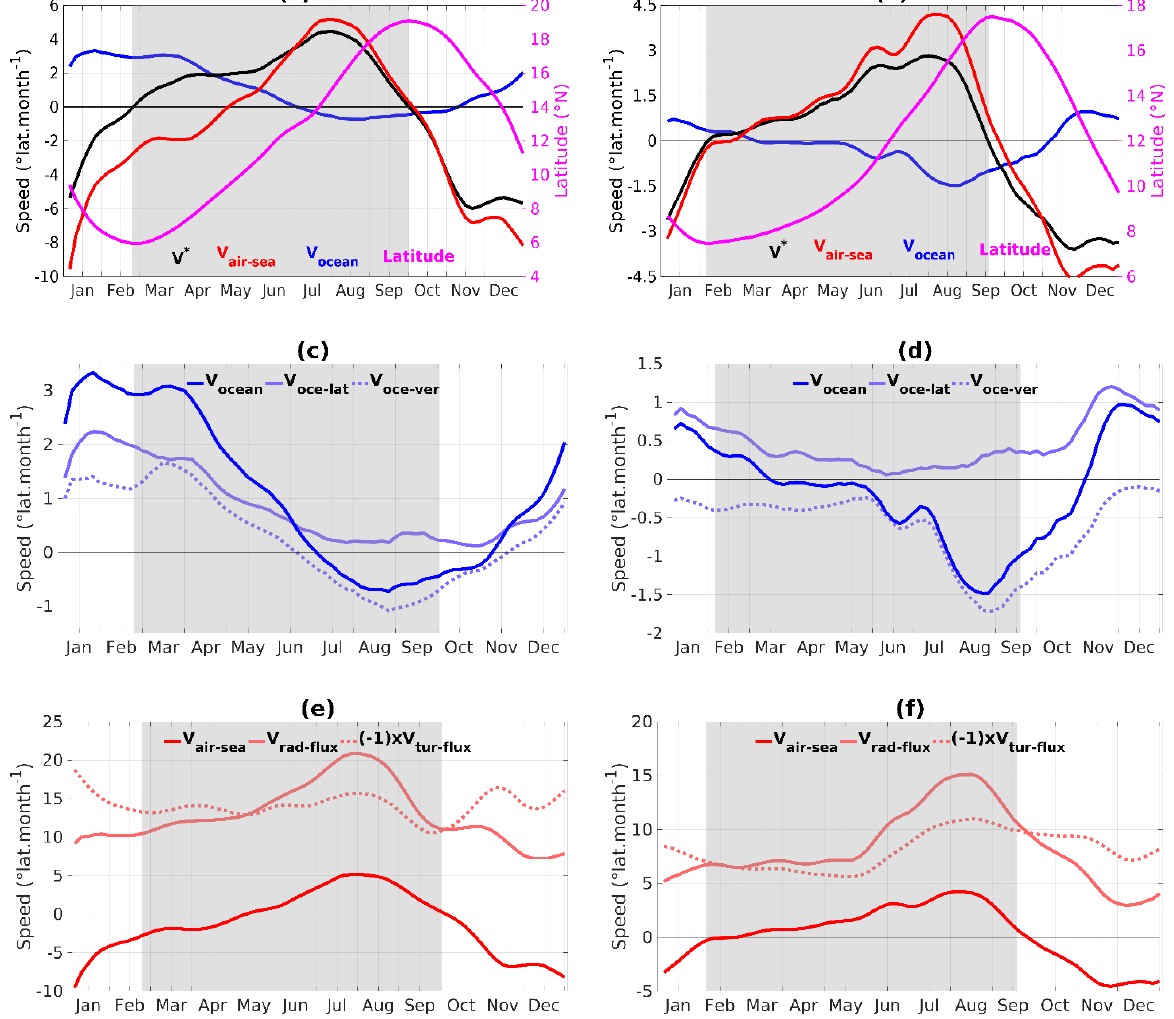
Figure 5. Velocity contributions ( ◦ lat.month − 1 ) for NB, averaged over the W30 ( left ) and E30 ( right ) sectors. ( a , b ) Total velocity (V*, black), contributions of air–sea fluxes (V air-sea , red) and oceanic processes (V ocean , blue), and NB latitude (magenta). ( c , d ) Contributions of lateral oceanic processes (V oce-lat , light blue) and vertical oceanic processes (V oce-ver , dashed light blue). ( e , f ) Contributions of radiative (V rad - flux , light red) and turbulent (V tur - flux , dashed light red) fluxes. Grey shading indicates the northward migration